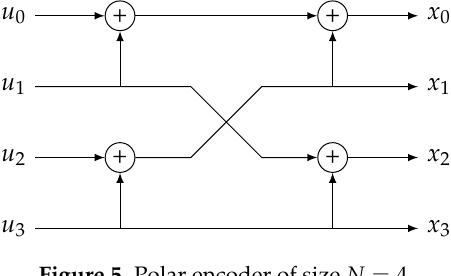
Figure 5. Polar encoder of size N =